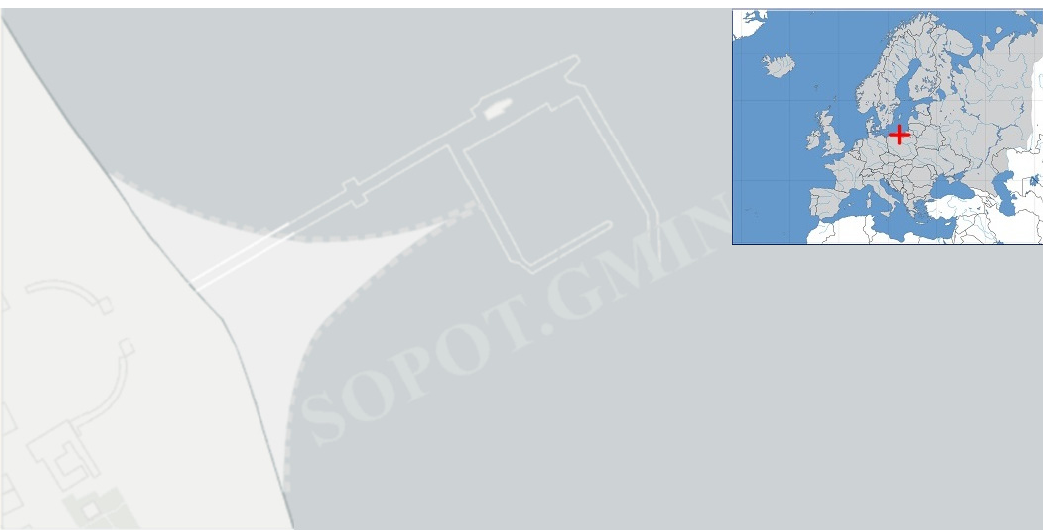
Figure 2. Forecast development model of the tombolo phenomenon in Sopot.